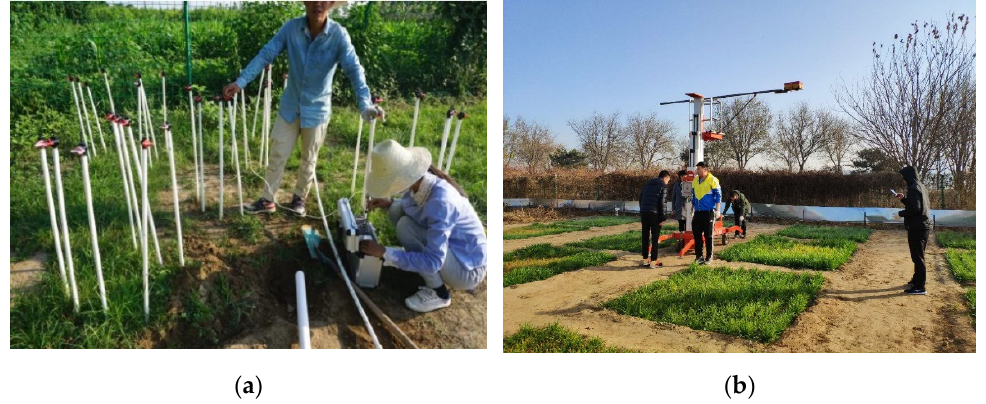
Figure 2. ( a ) Gas concentration data collection using GXH-3050E gas analyzer; ( b ) Infrared thermal images acquisition using Fluke ti55ft thermal imager.